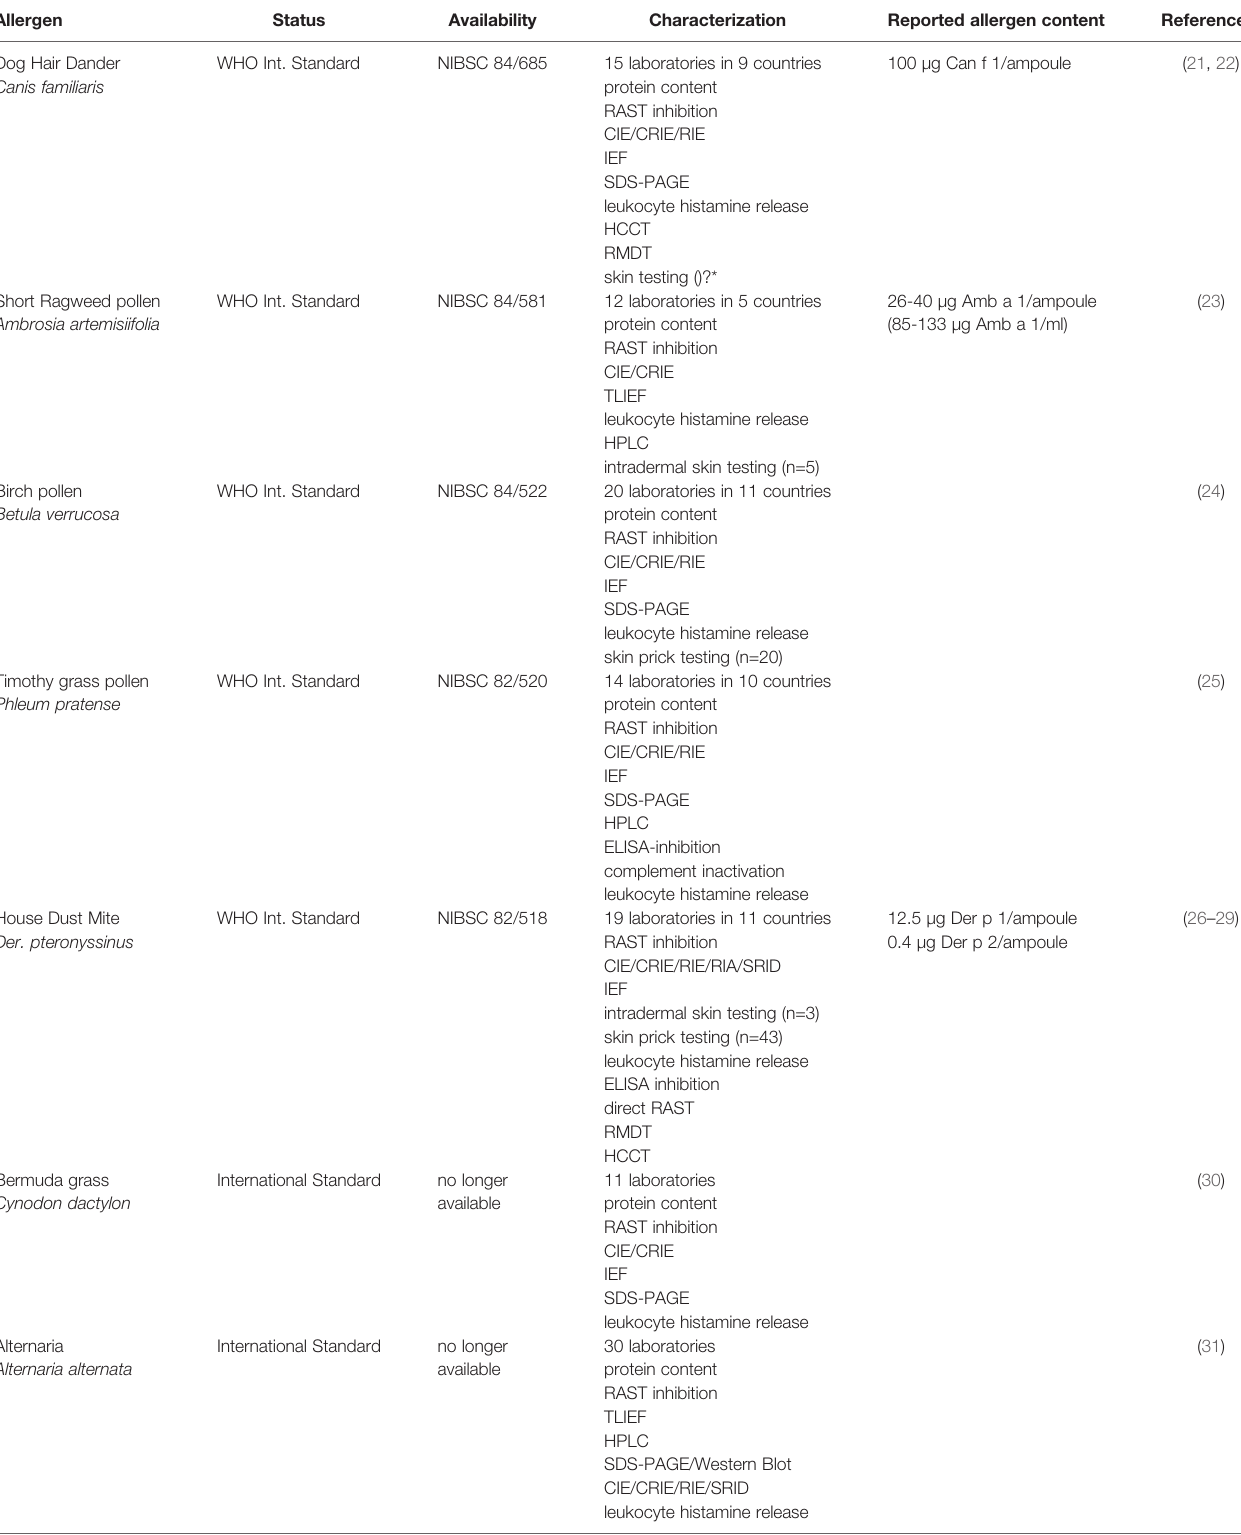
TABLE 2 | Allergen extract standards established by the WHO/IUIS Allergen Standardization Committee.